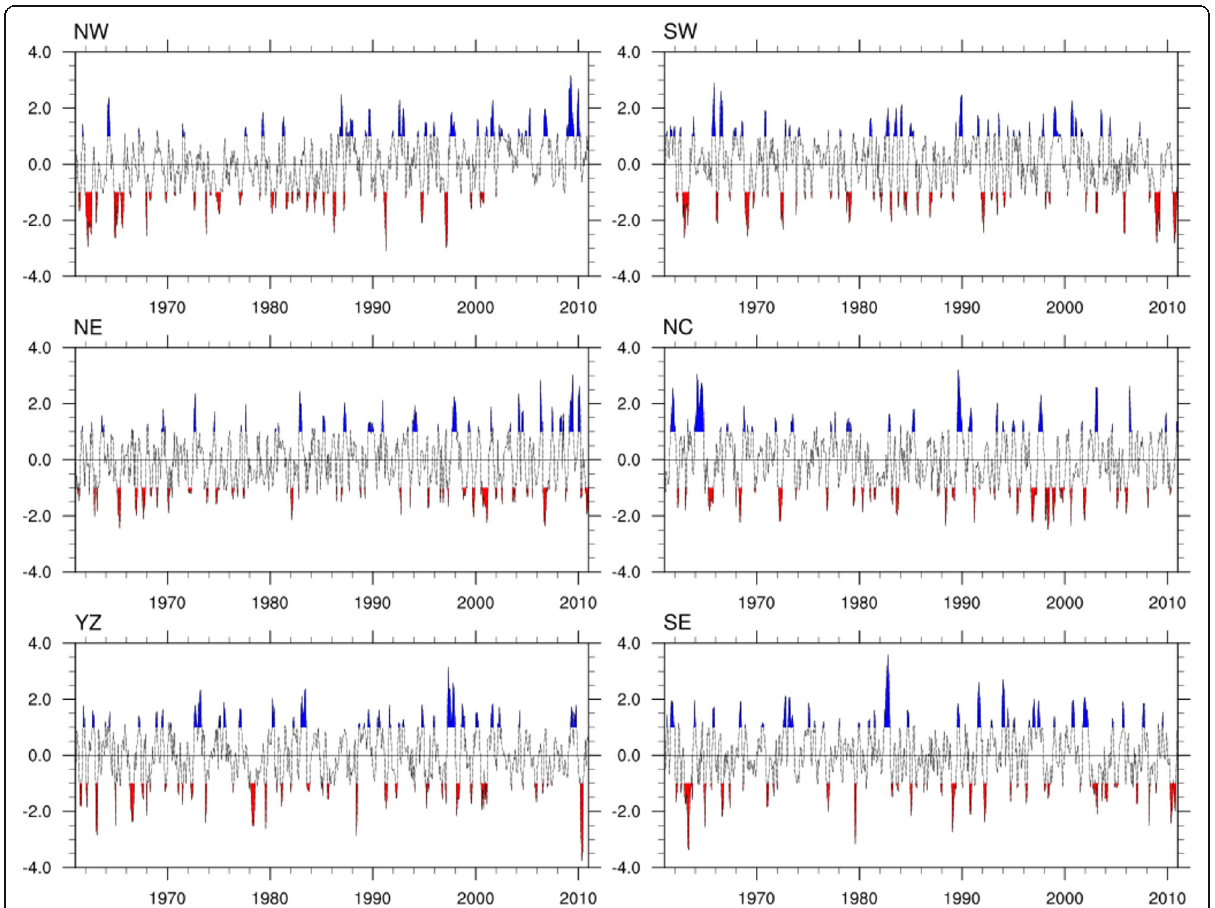
Fig. 4 Drought and flood events evaluated by SPI-03 in different subregions from 1961 to 2011. Drought and flood events are shaded red and blue ,